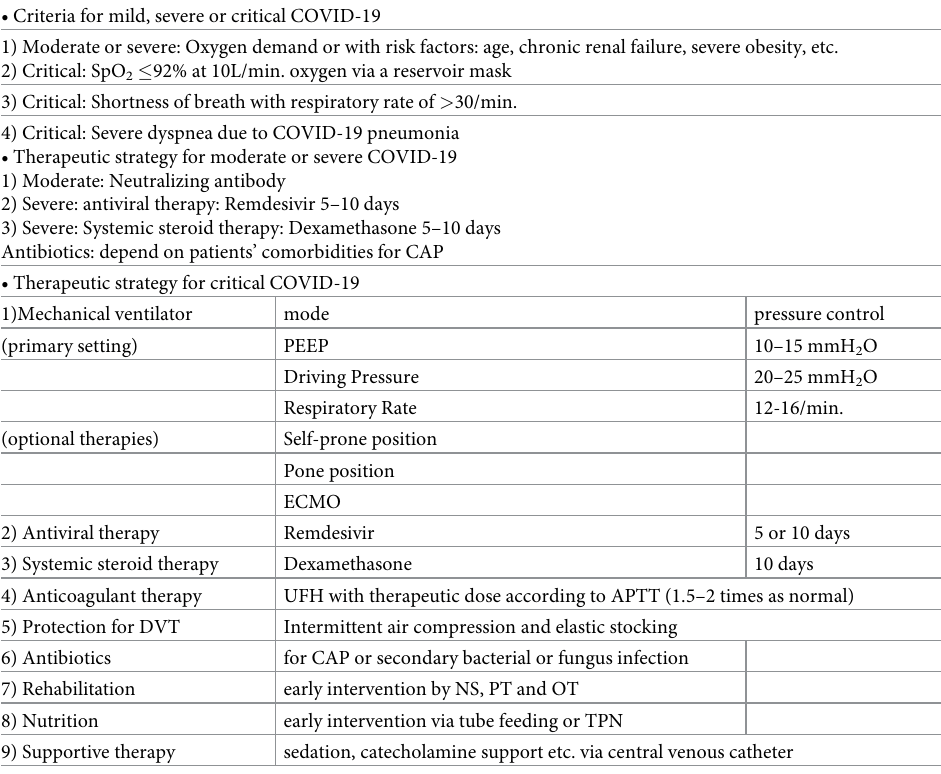
Table 1. Severity classification criteria and therapeutic strategy for critical